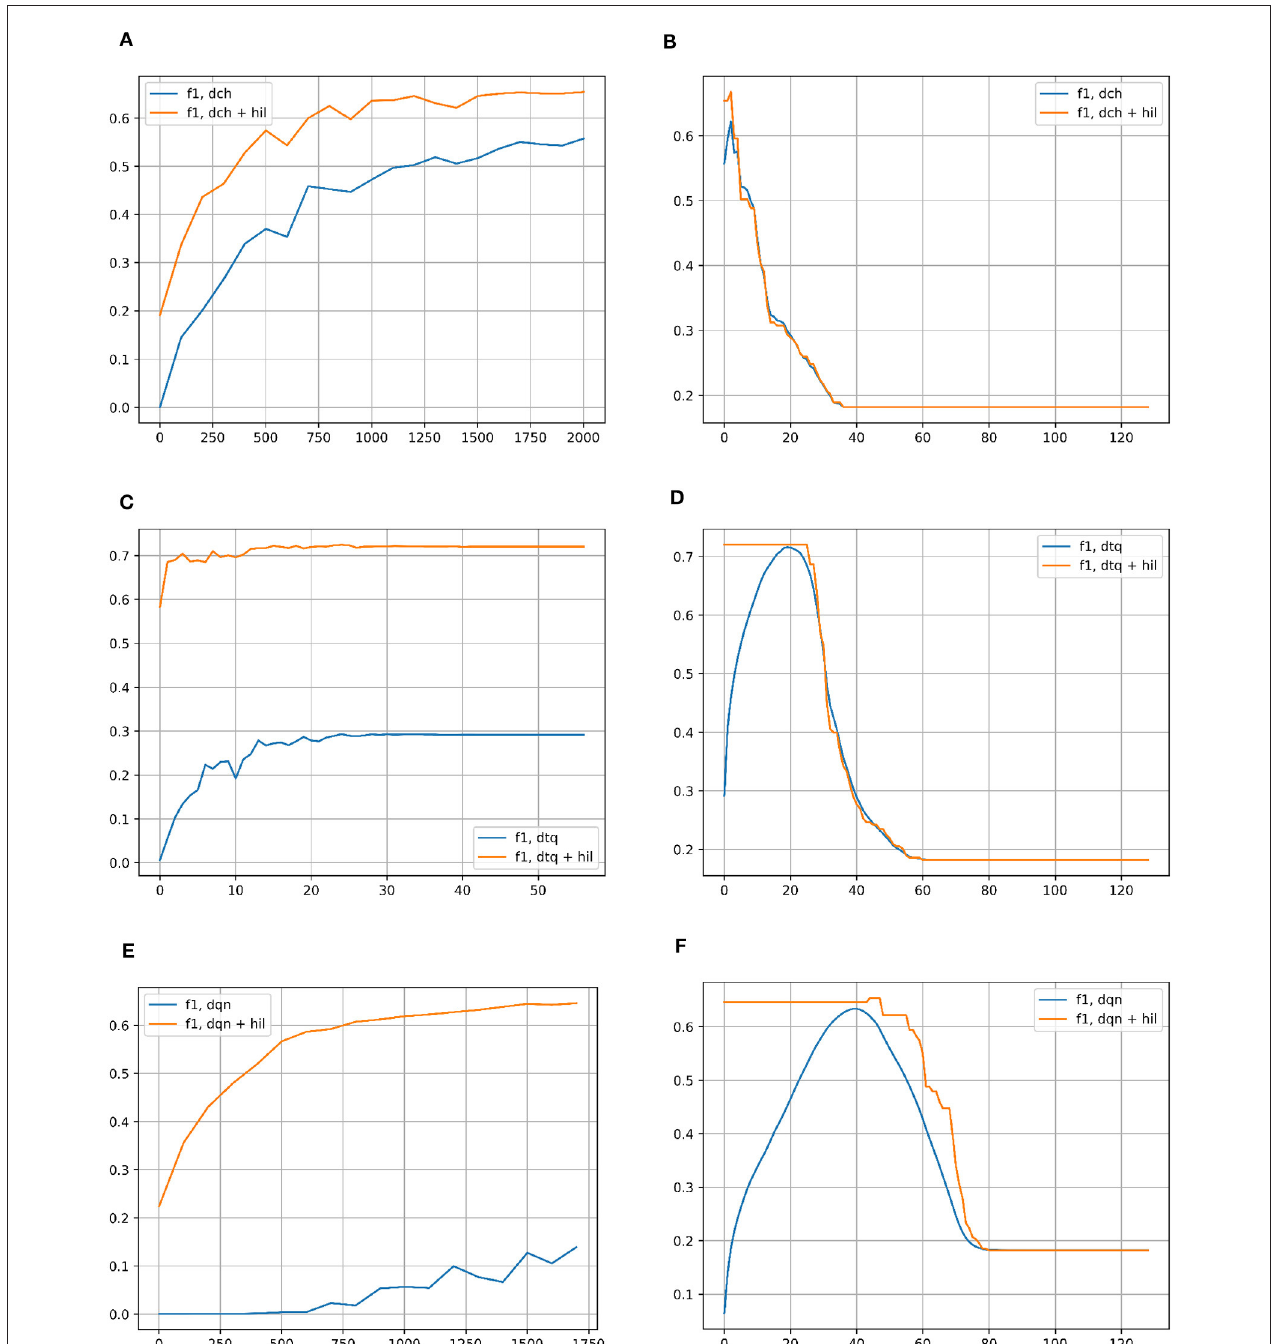
FIGURE 6 | (A) F1 score for classification on the CIFAR-10 dataset with DCH with and without the HIL, as a function of the number of iterations of training of the DCH network. (B) F1 score for classification on the CIFAR-10 dataset with DCH with and without the HIL, as a function of the Hamming Distance for classification. The networks are fully trained to the end point shown in subplot (A) . (C) F1 score for classification on the CIFAR-10 dataset with DTQ with and without the HIL, as a function of the number of iterations of training of the DTQ network. (D) F1 score for classification on the CIFAR-10 dataset with DTQ with and without the HIL, as a function of the Hamming Distance for classification. The networks are fully trained to the end point shown in subplot (C) . (E) F1 score for classification on the CIFAR-10 dataset with DQN with and without the HIL, as a function of the number of iterations of training of the DQN network. (F) F1 score for classification on the CIFAR-10 dataset with DQN with and without the HIL, as a function of the Hamming Distance for classification. The networks are fully trained to the end point shown in subplot (E) . Baseline networks are shown in blue, while the same network with a HIL appended to the end is shown in yellow. Note that in the left column of subplots, the Hamming Distance for classification is set to 2 for inlier/outlier count. The left column of results show that the HIL boosts the speed at which the network trains,